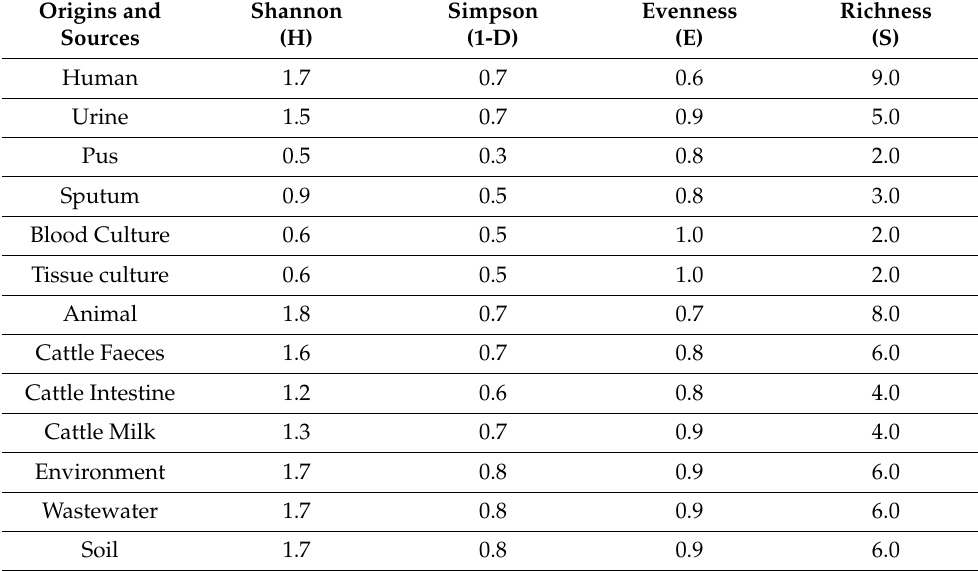
Table 4. Diversity indices values for the human, animal, and environmental E. coli